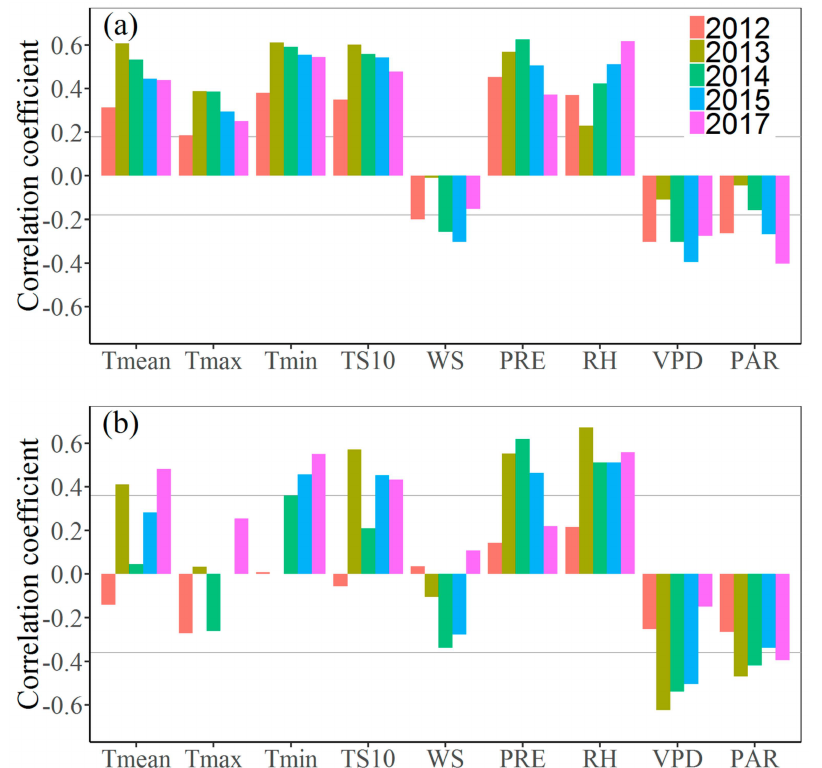
Figure 5. Correlation coe ffi cients between daily ( a ) and weekly ( b ) means of growth-induced irreversible stem expansion (GRO rate) and corresponding climate variables for the years 2012–2015 and 2017. Gray lines indicate correlations significant at the p ≤ 0.01 level. T mean : mean air temperature; T max : maximum air temperature; T min : minimum air temperature; TS10: mean soil temperature at 10 cm depth; WS: wind speed; PRE: precipitation; RH: relative humidity; VPD: vapor pressure deficit; PAR: photosynthetic active